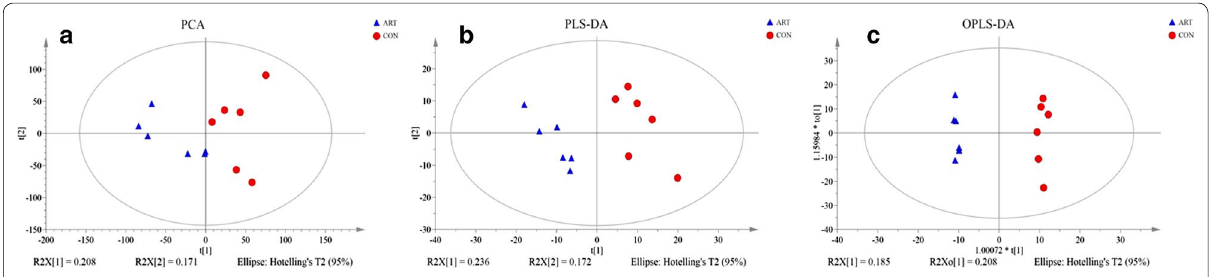
Fig. 4 Principal component analysis ( a ), corresponding PLS-DA validation plots ( b ), and OPLS-DA score plots ( c )